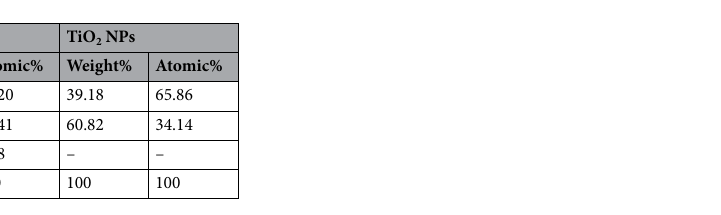
Table 1. Weight percentage and atomic percentage of elemental composition of Fe@TiO 2 NPs and TiO 2 NPs.